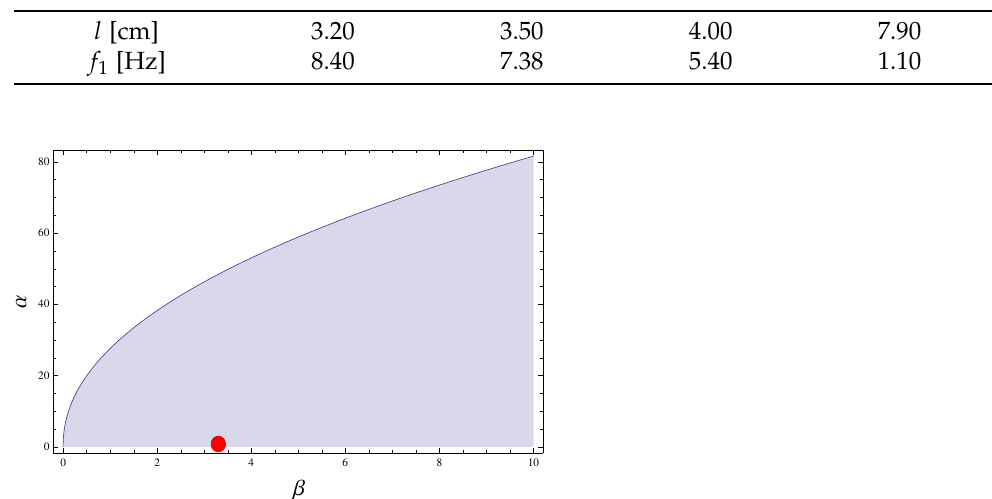
Table 1. Values of natural frequency of vibration, f 1 , of the cantilever for the several length l .